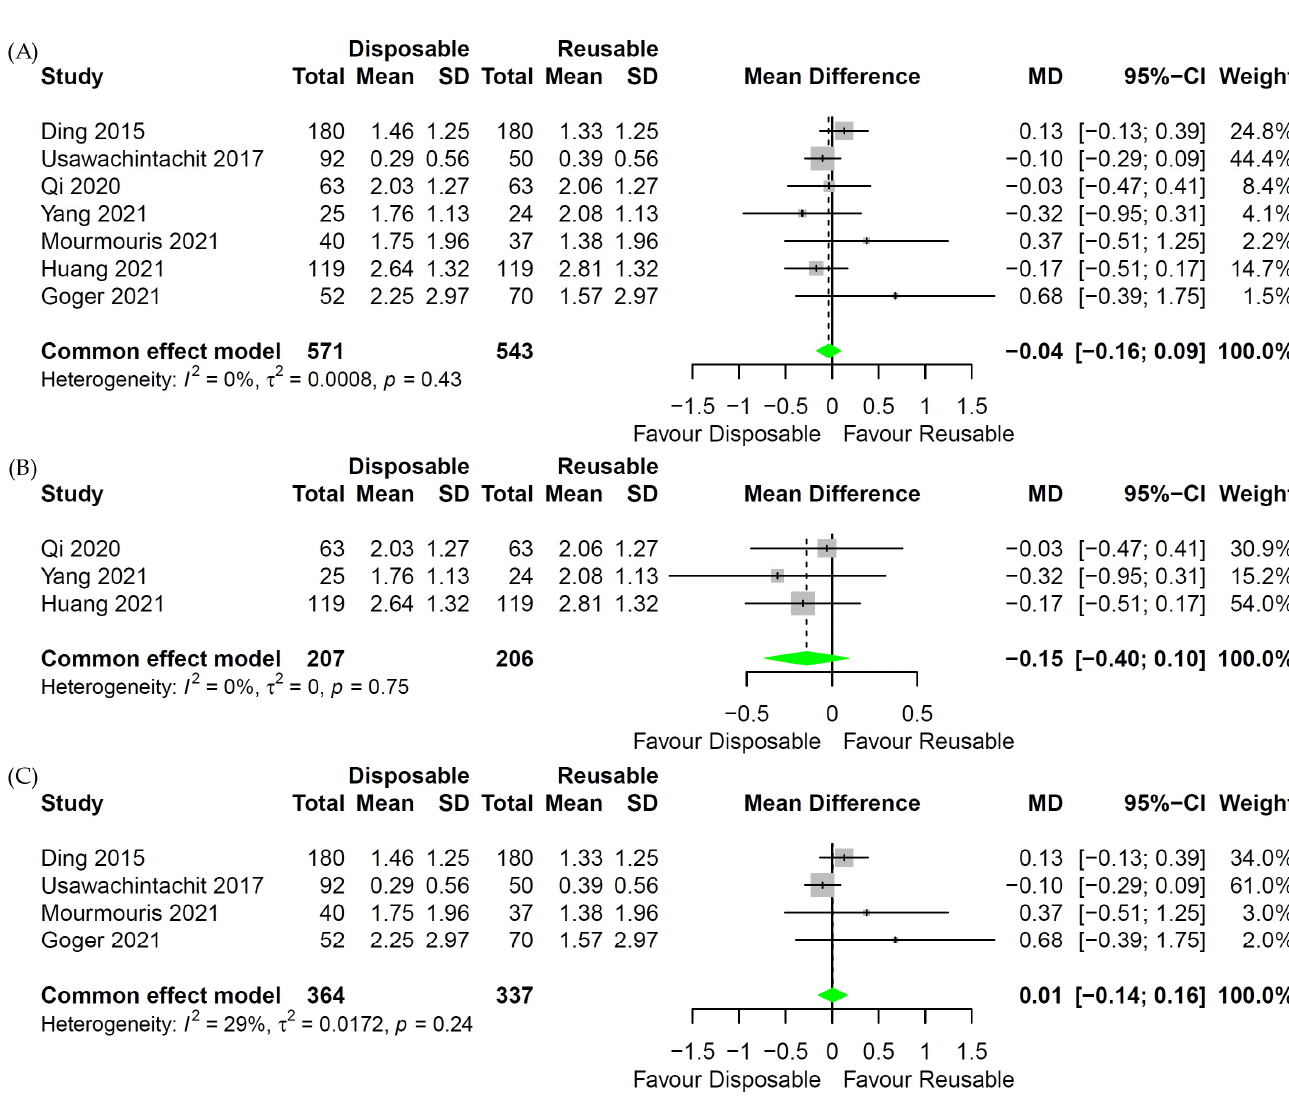
Figure 5. Forest plot for length of hospital stay (LOS) between disposable and reusable flexible ureteroscopic stone surgeries (fURS). ( A ) LOS of disposable and whole reusable fURS. ( B ) LOS of disposable and digital reusable fURS. ( C ) LOS of disposable and fiber-optic reusable fURS [17,19,20,22,23,25,26].